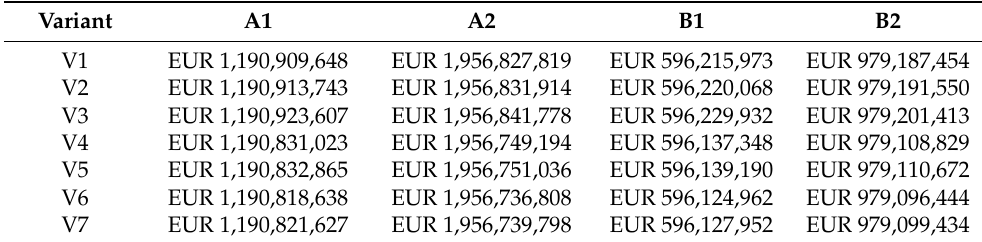
Figure 2. Investment and operating costs for street lighting installations (source: original work). NPVs were also determined for the various options (Table 8). Table 8. NPVs for the various street lighting replacement options.